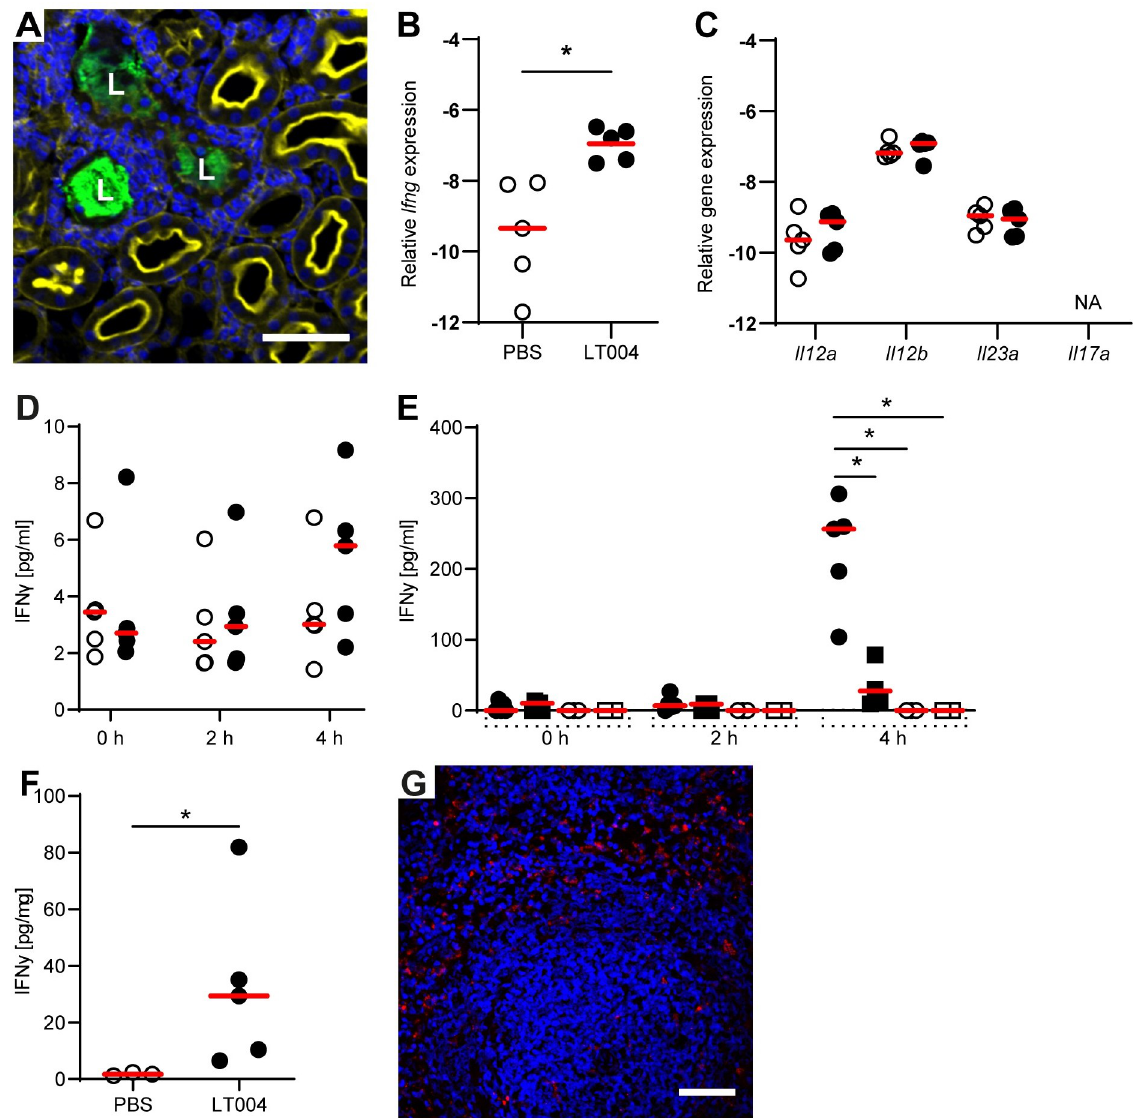
Fig 1. Local kidney infection triggers IFN γ expression in the spleen. ( A ) Ex vivo confocal imaging of kidney tissue 4 h after microinfusion of LT004 shows bacteria (green) localized to the lumen (L) of an infected tubule. Hoechst stain (blue) shows nucleated cells around the infected tubule. Actin staining (yellow) show the apical microvilli of uninfected proximal tubules. Scale bar = 50 μ m. ( B ) Relative Ifng mRNA expression in spleens 4 h after kidney infection with LT004 (black circles) or sham-infection (PBS-infused, unfilled circles). Expression in relation to the reference gene Gapdh (delta CT) is shown. � = p < 0.05 determined by Kruskal-Wallis and Dunn’s correction (this group was run in parallel to the group shown in Fig 3D and therefore grouped analysis comparing three groups was performed). n = 5 in each group. ( C ) Relative Il12a , Il12b , Il23 and Il17 mRNA expression compared to the reference gene Gapdh (delta CT) is shown for LT004-infected (black circles) and sham-infected (PBS-infused, white circles) animals. NA = not amplified. ( D ) IFN γ in serum from rats with kidney infection (LT004, black circles) and sham-infected (PBS-infused, white circles) at 0, 2, and 4 h after microinfusion into one renal tubule. ( E ) IFN γ in serum from animals after sham-splenectomy (circles) or full splenectomy (squares). Black shapes indicate infection with LT004 (microinfusion into three renal tubules); white shapes represent PBS infusion (white). ( F ) ELISA measurement of IFN γ in splenic tissue from sham-splenectomised animals after 4 h of kidney infection with LT004 (black circles) or PBS-infusion (white circles). ( G ) Ex vivo confocal imaging of spleen of a sham-splenectomised animal 4 h after kidney infection with LT004 shows IFN γ (red) mainly in the red pulp and marginal zone, distinguished by nucleated cells (Hoechst stain, blue), scale bar = 50 μ m. Individual data points and median values (red bars) are plotted in (B-F), n = 3–5 in each group. � = p < 0.05 determined by two-way ANOVA with Bonferroni’s or Turkey’s test in (D and E) respectively or Mann-Whitney in (C and F). Statistical significance was set to p < 0.001 in (C) to adjust for multiple comparisons. Images in (A) and (G) are representative of n = 5.